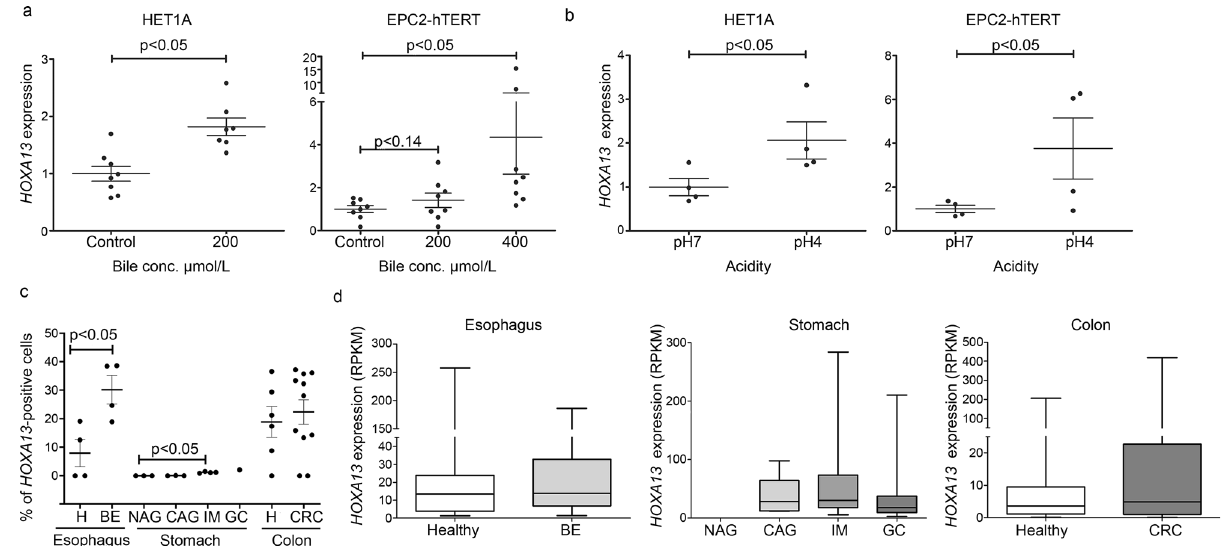
Fig. 3 Number of HOXA13 + cells rather than cellular expression levels are associated with metaplasia. Exposure to bile (at pH 7) ( a ) or to acid ( b ), in two in vitro model systems of gastroesophageal re fl ux disease (GERD), marginally induces the expression of HOXA13 from low baseline expression levels in two primary immortalized squamous esophageal cell lines. Error bars represent the 95% CI of the mean. n = 4 independent experiments. For Het1a, two- tailed t -test was used ( p = 0.0096 in a, p = 0.0322 in b), for EPC2-hTERT Dunn ’ s multiple comparisons test in a (control vs. 200 µ M, p > 0.99; control vs. 400 µ M, p = 0.0112; 200 µ M vs. 400 µ M, p = 0.14), one-tailed t -test in b , p = 0.0486. c The number of HOXA13 -postive cells are increased in Barrett ’ s esophagus (BE) and intestinal metaplasia (IM) as compared to normal esophagus or stomach tissue. Healthy and BE esophageal samples are derived from the same patients. Mean± SEM are shown. n = 4 individuals for esophagus, n = 3 for NAG, CAG, n = 4 for IM, n = 1 for GC, n = 6 for healthy colon, n = 11 for CRC. Graphs are based on the analysis of single cell RNA data seq 21 , GSE134520 82 , GSE81861 83 . Two-tailed t -test was used for esophagus ( p = 0.0443) and colon ( p = 0.6808), one-way analysis of variance for stomach with Dunnett ’ s Multiple Comparison Test ( p < 0.0001). d HOXA13 expression level per cell is unchanged. Expression level presented in HOXA13 + cells only. H healthy, BE Barret ’ s esophagus, NAG non-atrophic gastritis, CAG chronic atrophic gastritis, IM intestinal metaplasia of stomach, GC early gastric cancer, and CRC colorectal cancer. n = 37 for H, n = 132 for BE, NA for NAG, n = 5 for CAG, n = 163 for IM, n = 69 for GC, n = 37 for healthy colon, n = 87 for CRC of single cells from the individuals mentioned in (c). For GC, statistics are not presented as data per patient was not provided. Boxplots with middle line is the median, the lower and upper hinges correspond to 25th to 75th percentiles, and whiskers representing min-max